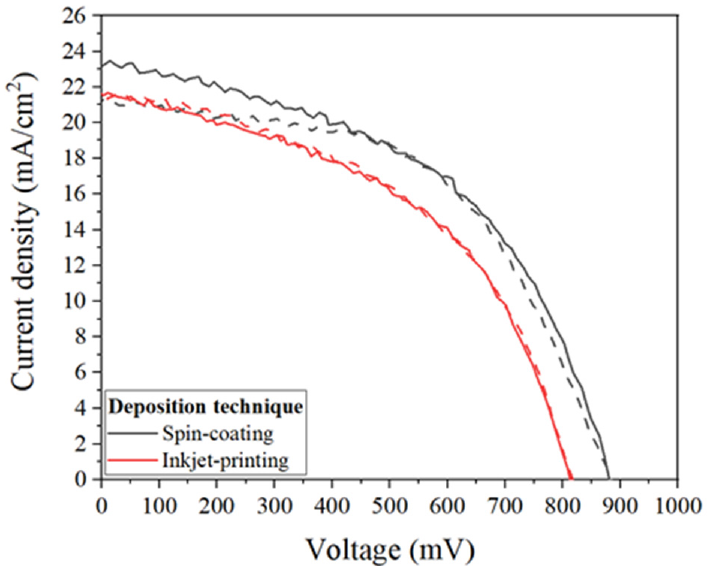
Figure 6. Representative J–V curves of the solar cells fabricated by the different deposition techniques of the perovskite absorbent